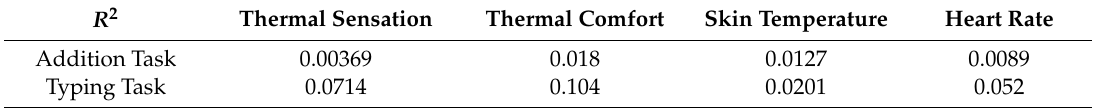
Table 3. Correlation R 2 between simulated office-work performance and different physiological